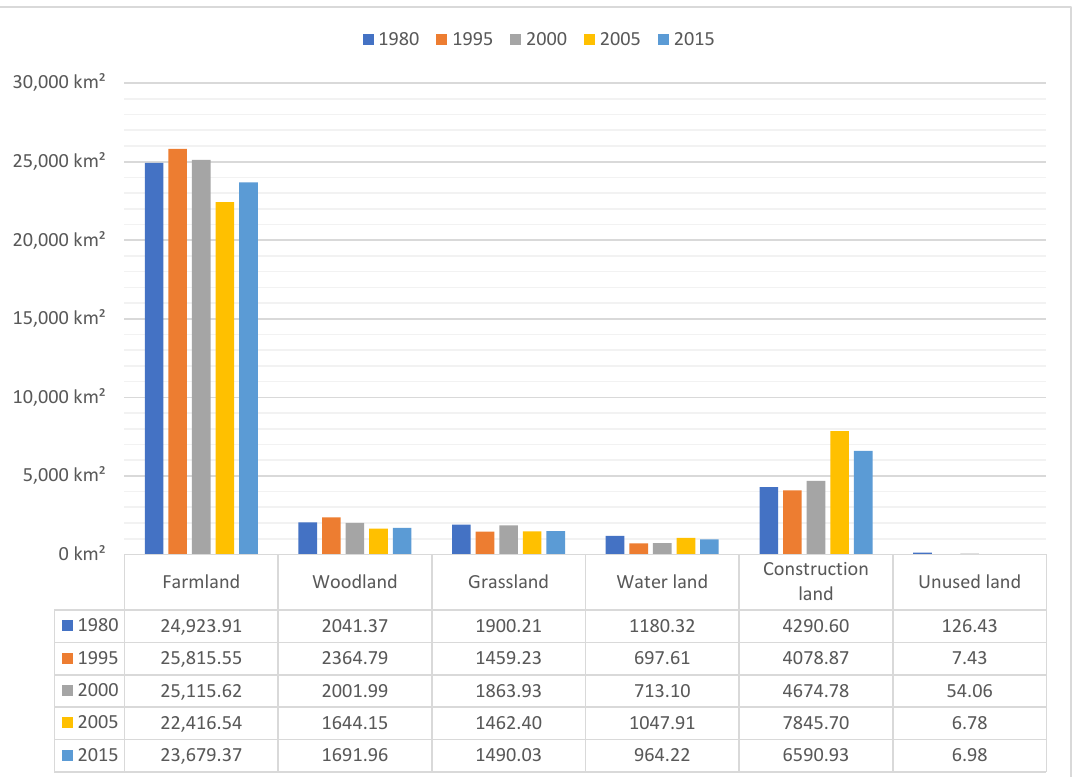
Figure 5. Land use change from 1980 to 2015.